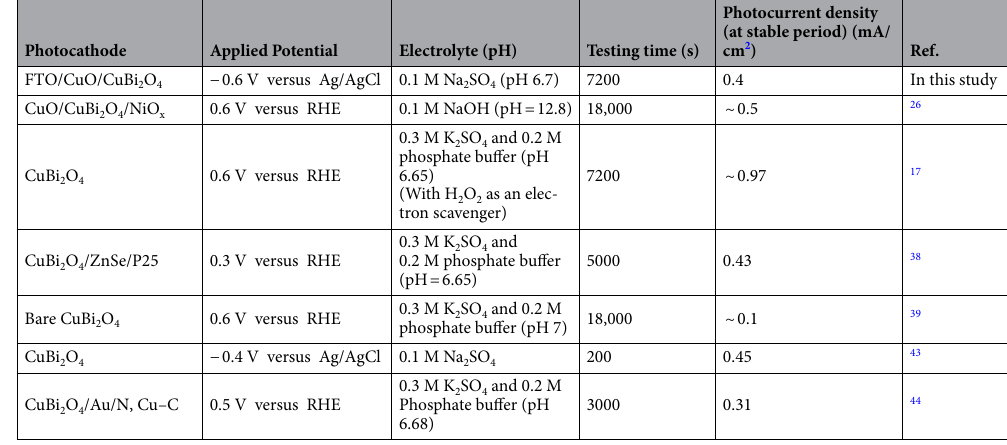
Table 2. Comparing of the photoelectrochemical stabilities of CuBi 2 O 4 -related